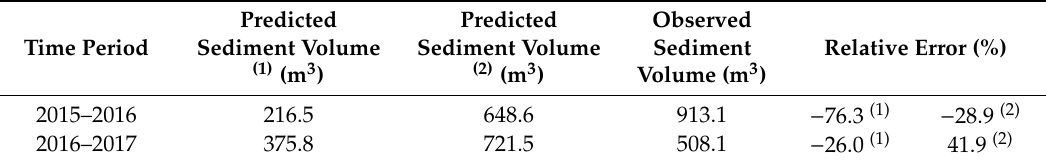
Table 6. Comparison between the bathymetric measured data and modelled data of the sediment budget in the Svacenick ý reservoir